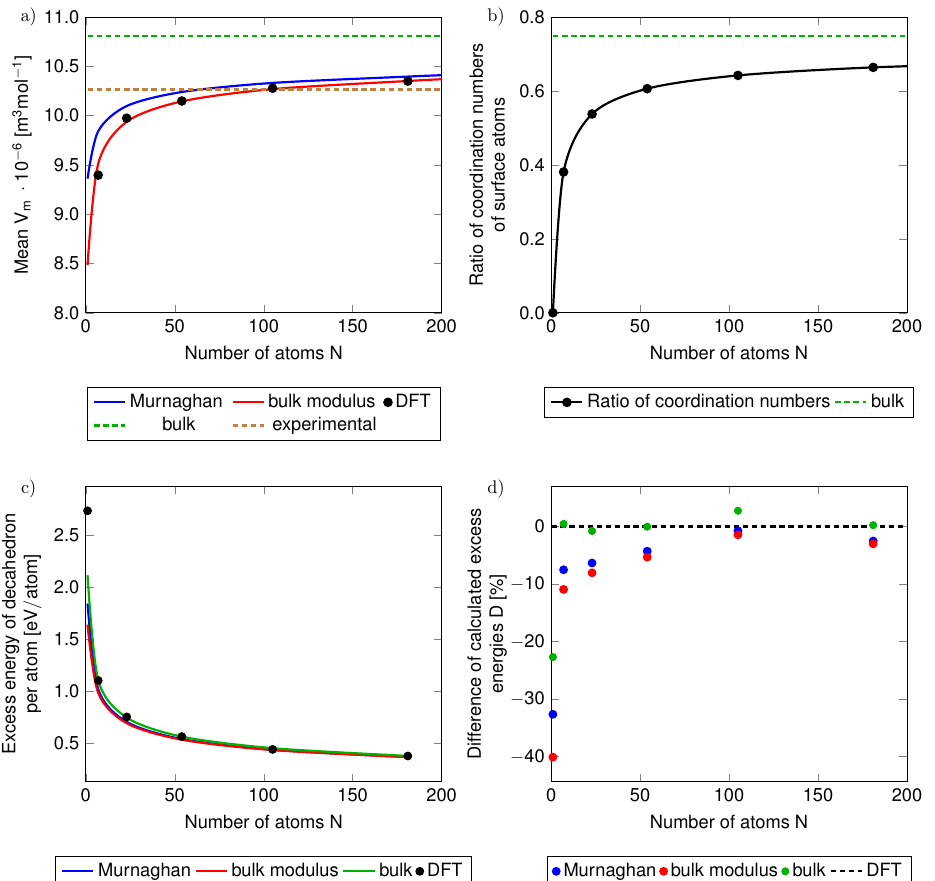
Figure 5. The dependencies of ( a ) the molar volume and ( b ) the ratio of coordination numbers of nanocluster surface atoms with respect to that of {111} surface of the bulk (which is equal to 9) as functions of the number of atoms in the studied nanoclusters/nanoparticles. The green dashed lines in parts ( a , b ) are the values corresponding to the bulk (or its {111} surface), blue and red lines represent volumes assigned to nanoparticles using Murnaghan equation and the definition of the bulk modulus, respectively. The full black circles represent results of direct DFT calculations of nanoparticles. The part ( c ) shows absolute (and part ( d ) also relative) differences of excess energies per atom determined by our phenomenological thermodynamic approach w.r.t. to the excess energies of the direct DFT calculations of nanoparticles when the volume of nanoparticles in the phenomenological thermodynamic modeling is determined from the Murnaghan equation (blue curves and blue data points in part ( d )), from the definition of the bulk modulus (red curves and red data points) and from determining the volume of the nanoparticles from the volume of bulk fcc Ag (green lines and green data points). Also added is the experimental molar volume (the horizontal brown dashed line in ( a